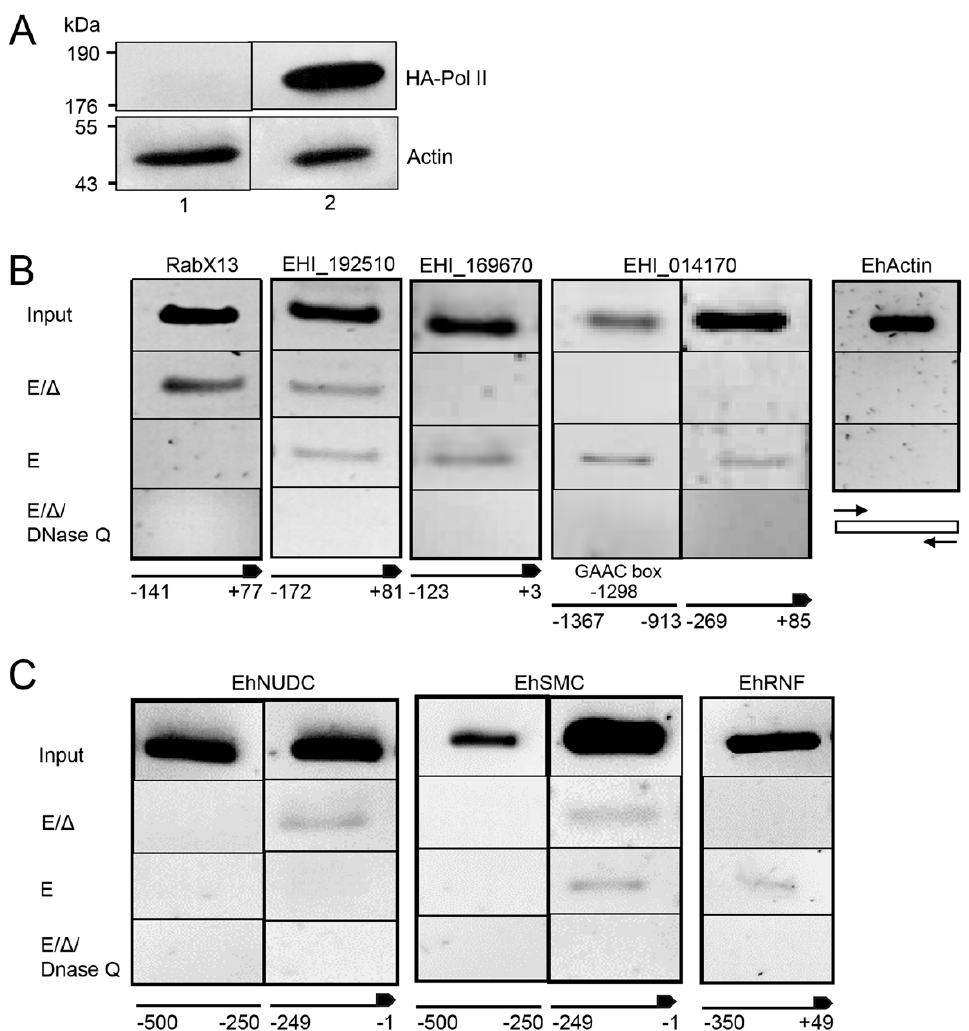
Figure 3. RNA Pol II binds to gene promoters regardless of their flicRNA-forming capacity. ( A ) E.